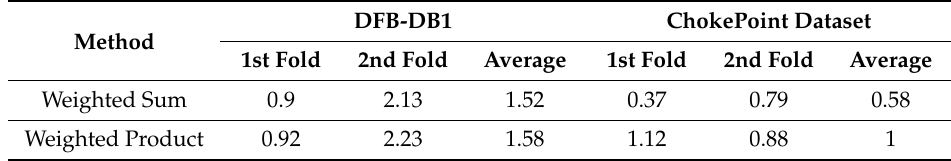
Table 8. Comparisons of EER by score-level fusion (unit: